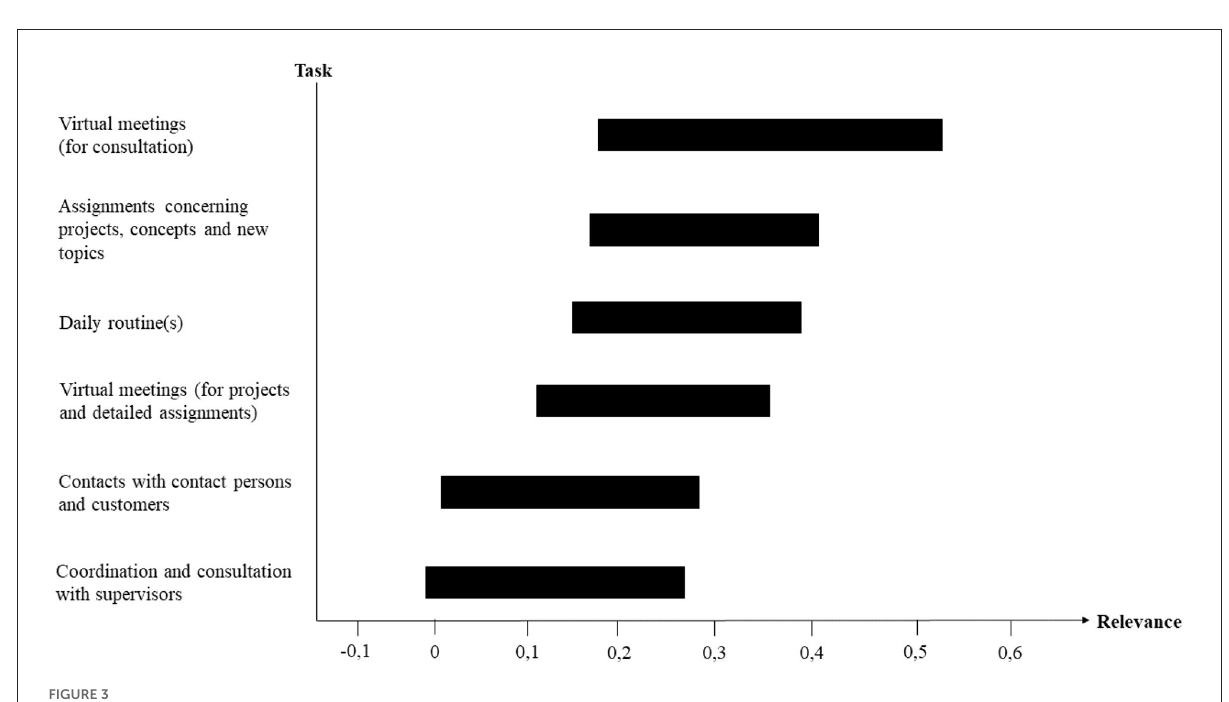
FIGURE3 Relevance of tasks that form telework tasks